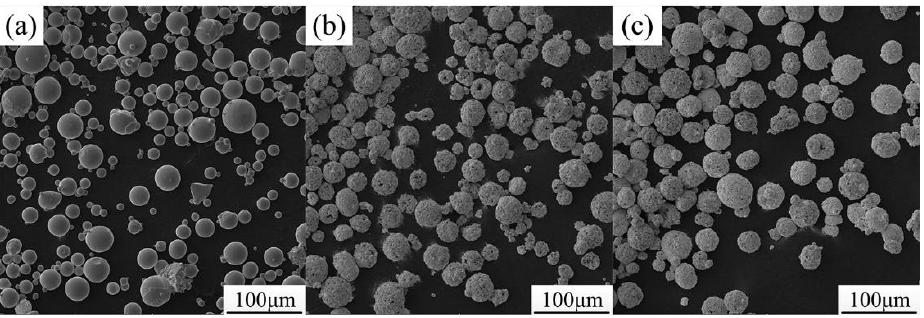
Figure 2. SEM images of feedstock powders: ( a ) Cobalt-based alloy, ( b ) WC-12Co, and ( c ) WC-17Co.